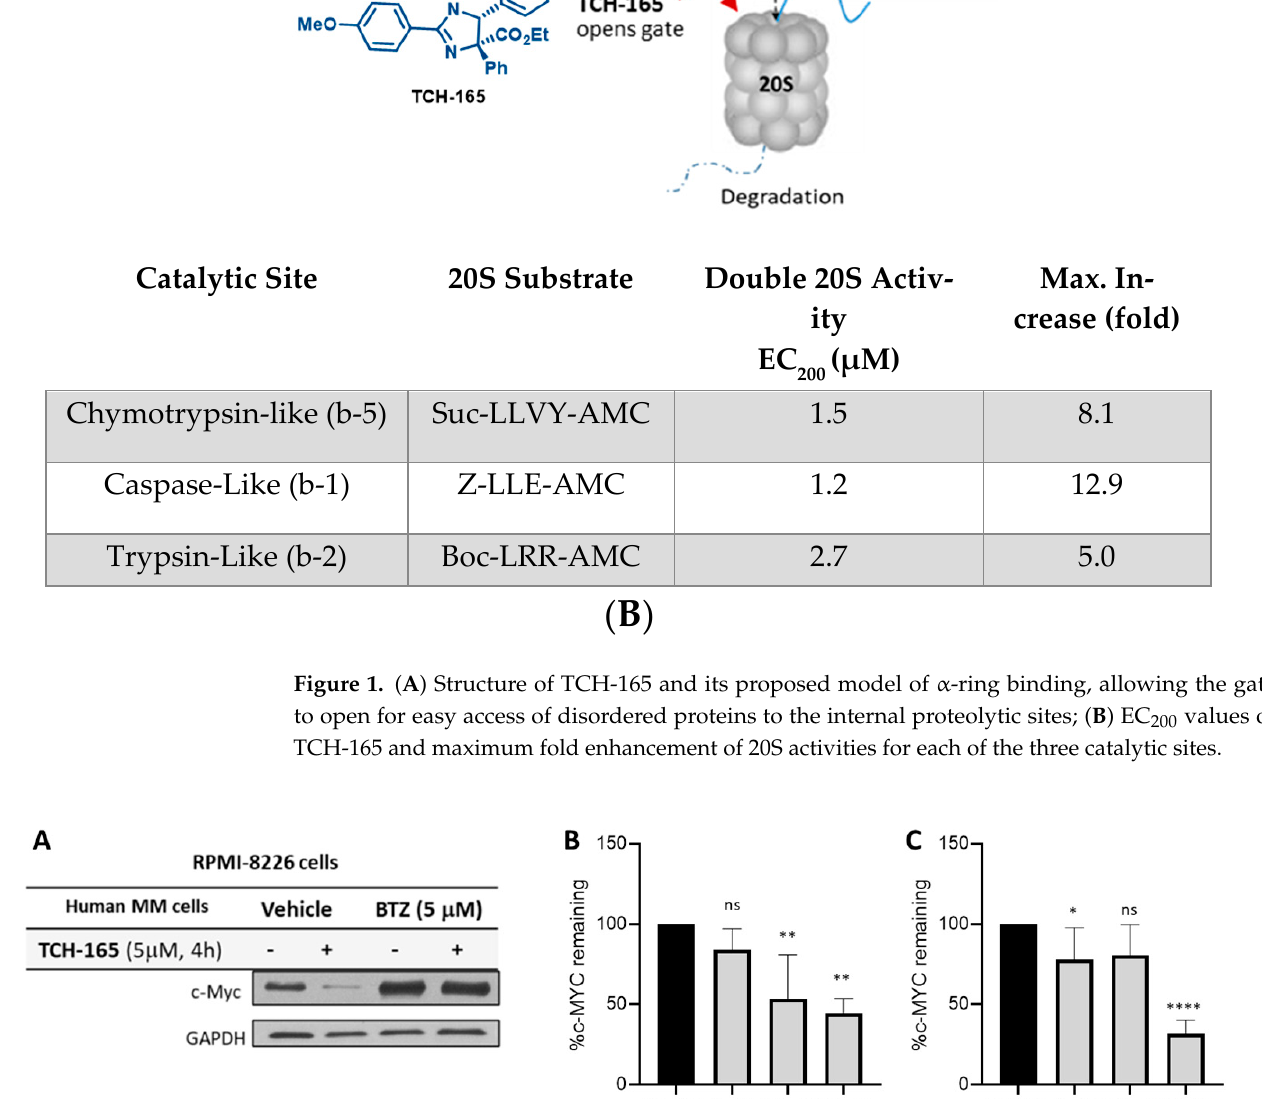
Figure 2. ( A ) Multiple Myeloma (RPMI-8226) cells treated with vehicle or TCH-165 (4 h, 5 mM) in the presence and absence of proteasome inhibitor BTZ (5 μ M); ( B ) percent MYC remaining in L363 cells treated with various concentrations of TCH-165 (n = 3); ( C ) percent MYC remaining in H929 cells treated with various concentrations of TCH-165 (n = 4). * p < 0.05, ** p < 0.01, *** p < 0.001, **** p < 0.0001) 3.3. 20S Proteasome Activation by TCH-165 Regulates MYC-Mediated Gene Transcription The ability of TCH-165 to modulate MYC-mediated gene transcription was evaluated using a luciferase reporter assay in HCT-116 cells with a stably transfected MYC-luciferase gene (Figure 3). Treatment of the cells with various concentrations of TCH-165 resulted in